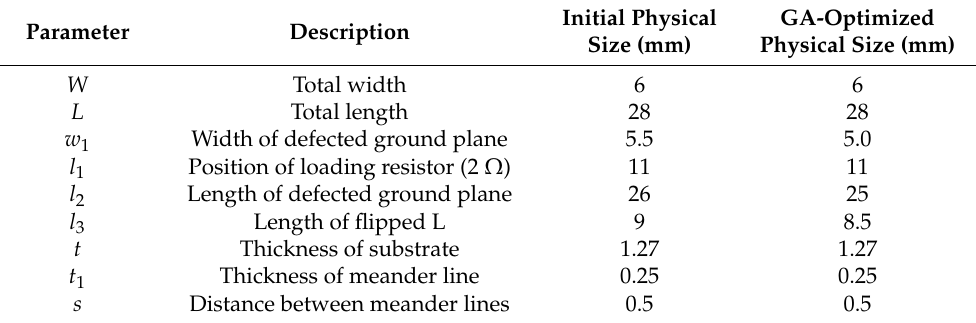
Table 2. Parameters of the proposed MICS/ISM meander-line microstrip antenna. Parameter